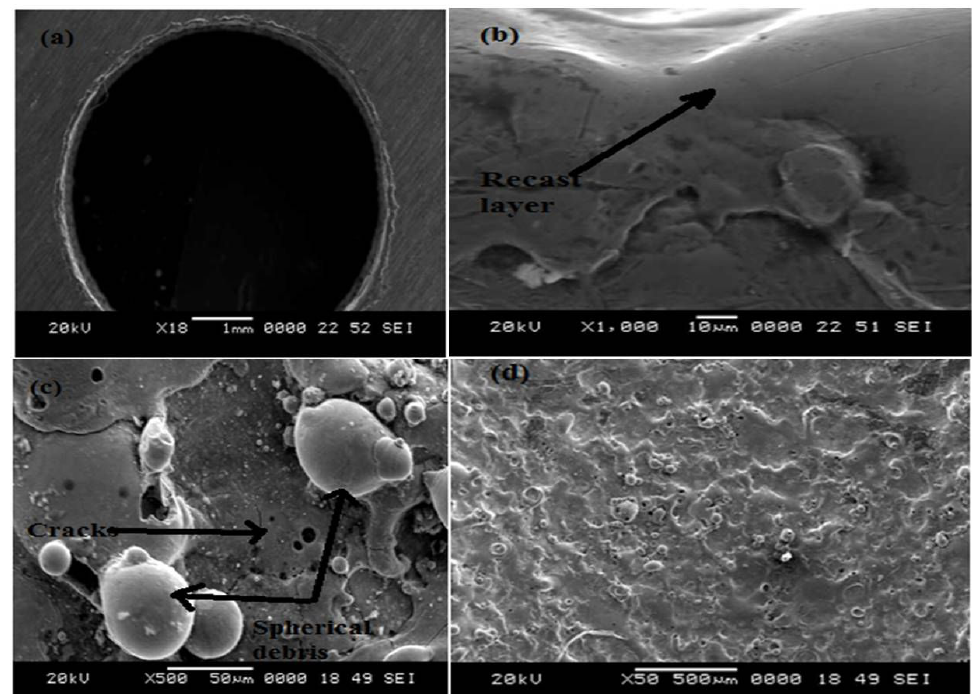
Figure 14: SEM micrograph of optimal setting at T on = 10 µ s; T off = 10 µ s; I p = 4